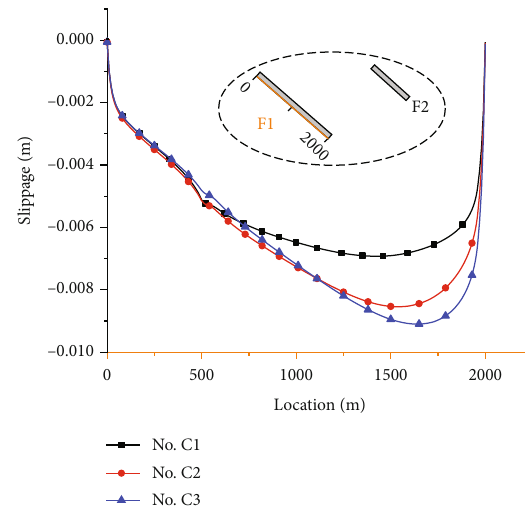
Figure 9: The fault slippage of F1 according to di ff erent fracturing regions (Nos. C1-C3).